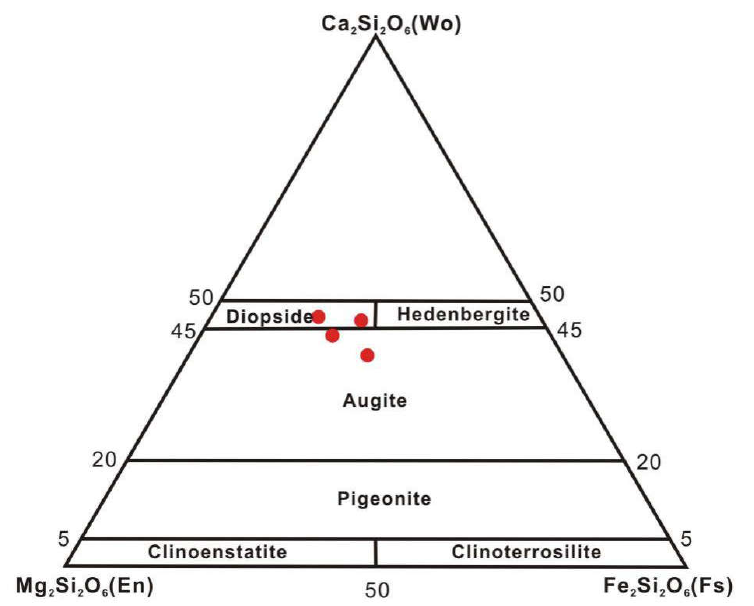
Figure 5. Diagram for classification of pyroxene in JingFenCui: Wo—wollastonite; En—enstatite; Fs—ferrosilite (modified after Morimoto, N. [11] and Liu, X.F. et al. [12]).